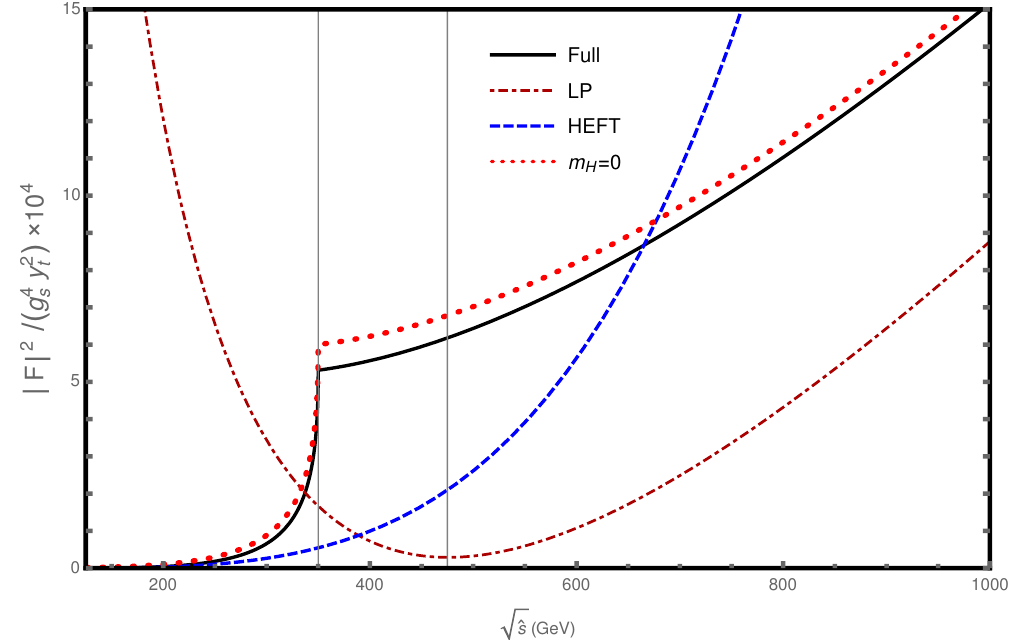
p ^ s : the full form